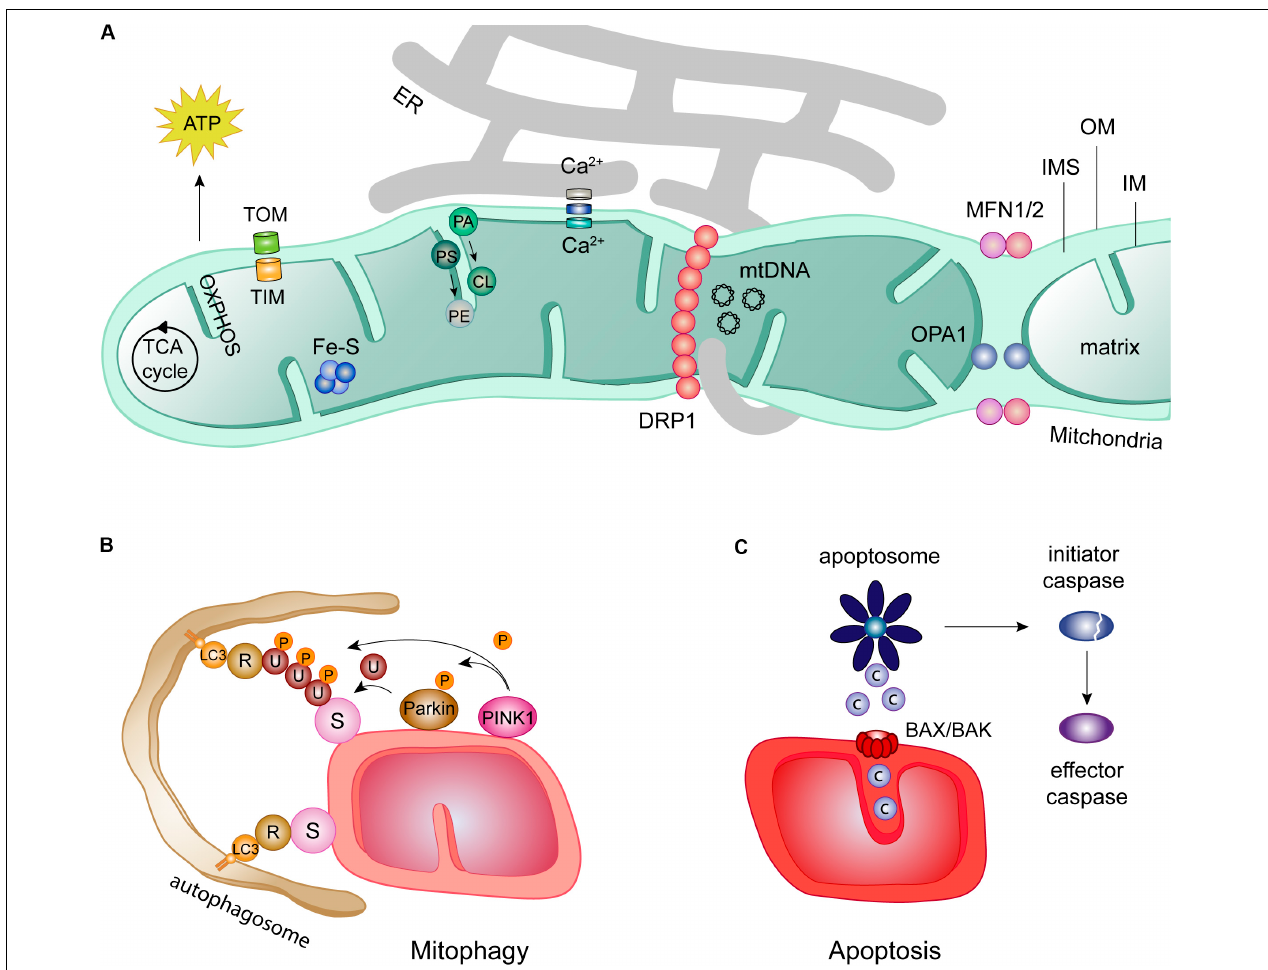
FIGURE 1 | Mitochondrial roles in health and disease. (A) Despite the presence of an own DNA in the mitochondrial matrix (mtDNA), most mitochondrial proteins are imported from the cytosol by two translocase complexes: the translocase of the outer membrane (TOM) and the translocase of the inner membrane (TIM). Mitochondria are hubs for several cellular processes, such as iron-sulfur clusters (Fe-S) assembly, metabolite oxidation by the tricarboxylic acid (TCA) cycle and ATP production via the oxidative phosphorylation chain (OXPHOS). Further, mitochondrial proximity to the endoplasmic reticulum (ER) regulates calcium (Ca 2 + ) buffering and phospholipid synthesis, e.g., cardiolipin (CL) and phosphatidylethanolamine (PE) from their ER precursors phosphatidic acid (PA), and phosphatidylserine (PS), respectively. ER-mitochondrial contacts also regulate mitochondrial fission, by facilitating the recruitment of DRP1 to the mitochondria. In turn, mitochondrial fusion requires the mitofusins MFN1 and MFN2 at the OM and OPA1 at the IM. (B) Mitochondrial function is kept in check by mitophagy, a quality control mechanism. Mitophagy can occur dependently or independently of ubiquitin. The canonical ubiquitin-dependent PINK1/Parkin pathway initiates with the accumulation of the kinase PINK1 at the OM, which recruits the E3 ligase Parkin. Ubiquitylation (U) of several OMM substrates (S) by Parkin and additional phosphorylation (P) of ubiquitin and Parkin generates a positive feedback loop increasing Parkin activity. The ubiquitin chains formed on OM substrates bind to the lipidated